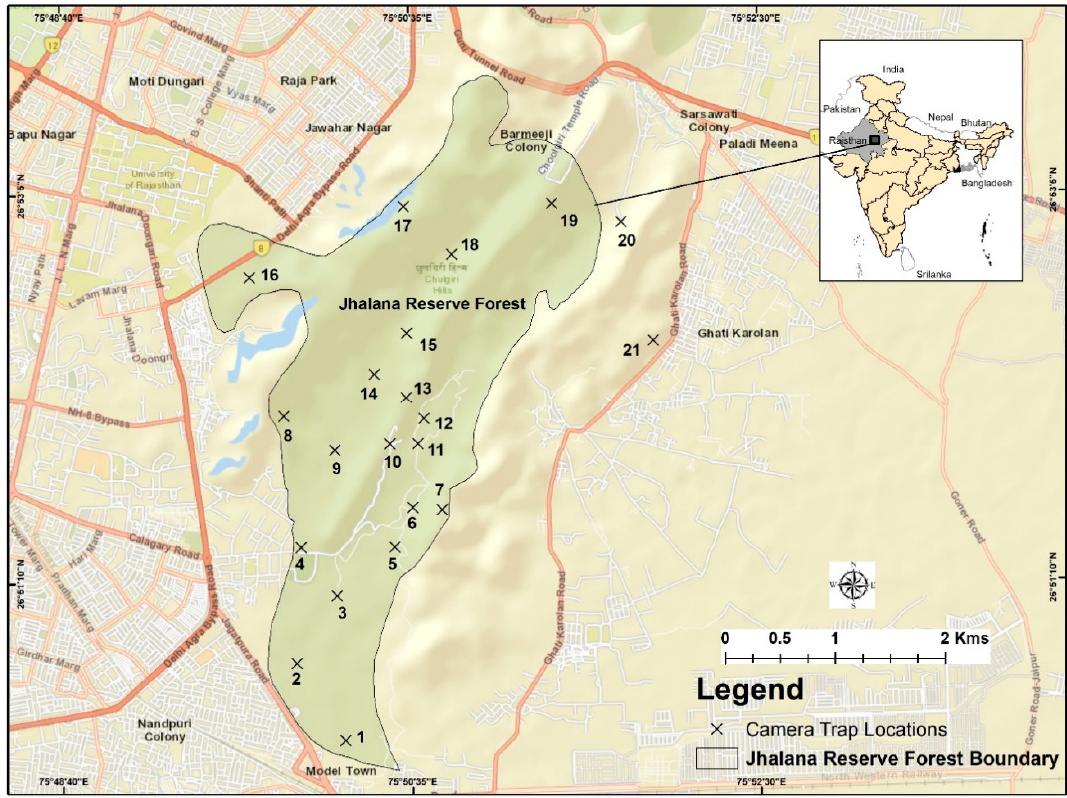
Figure 1. Map of the study area showing Jhalana Reserve Forest and its location along with the camera trap locations.